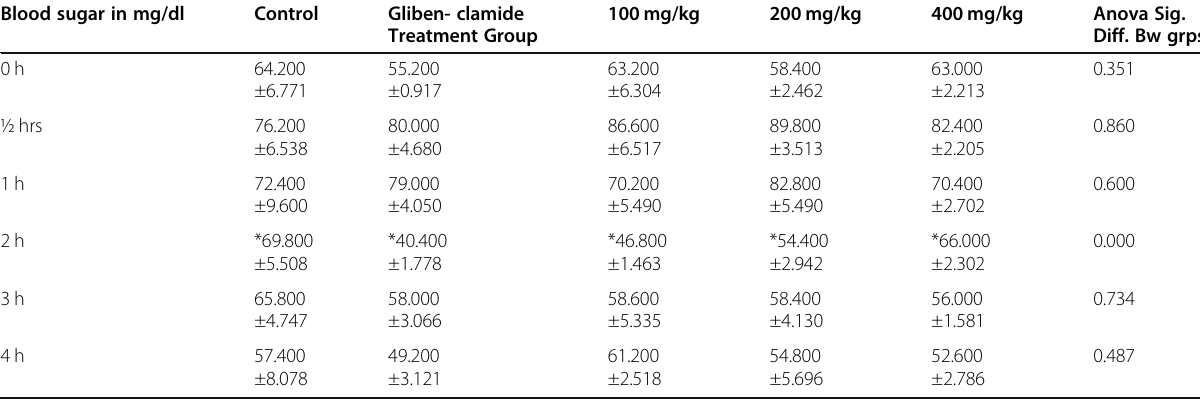
Table 3 Hypoglycaemic activity of A. inermis extract in normal rats Blood sugar in